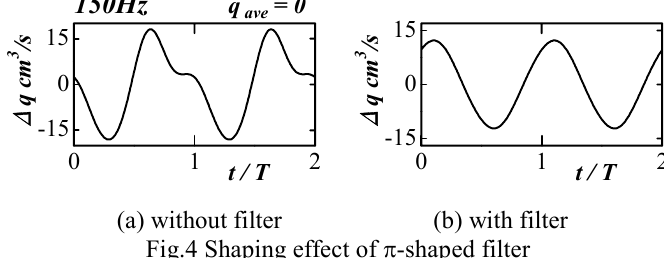
Fig.4 Shaping effect of π -shaped